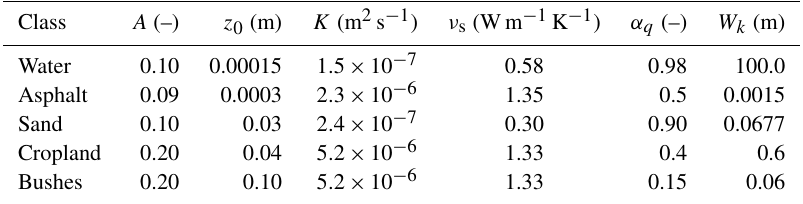
Table 1. The physical parameters for some surface cover classes as used in MITRAS: albedo ( A ), roughness length ( z 0 ), thermal diffusivity ( K ), thermal conductivity ( ν s ), soil water availability ( α q ), and saturation value for water content ( W k ).